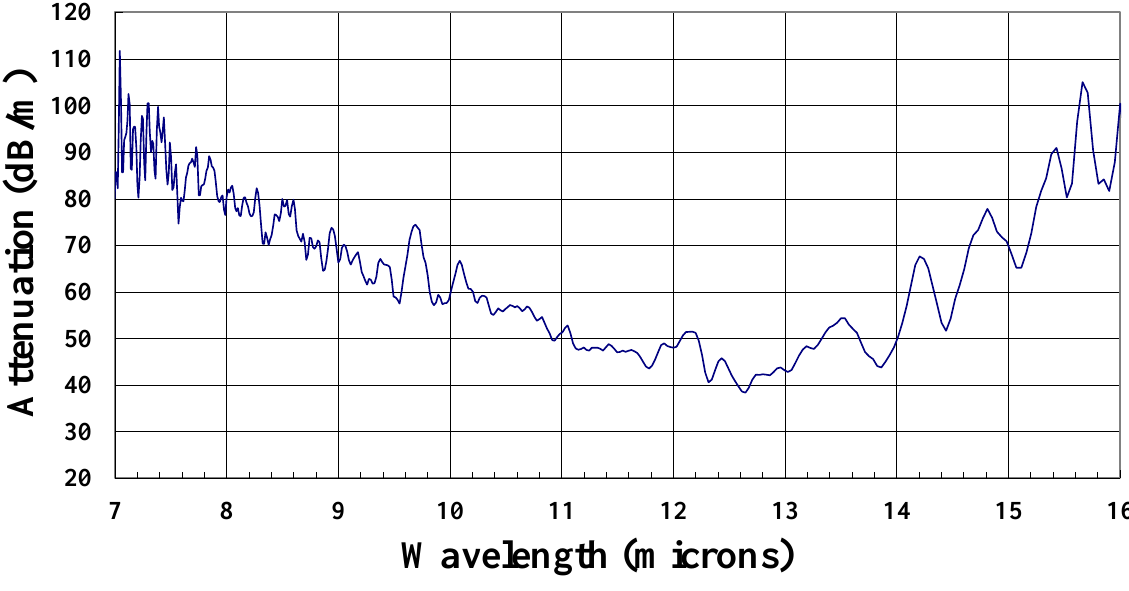
Figure 1. Attenuation curve of a Ge 12–13